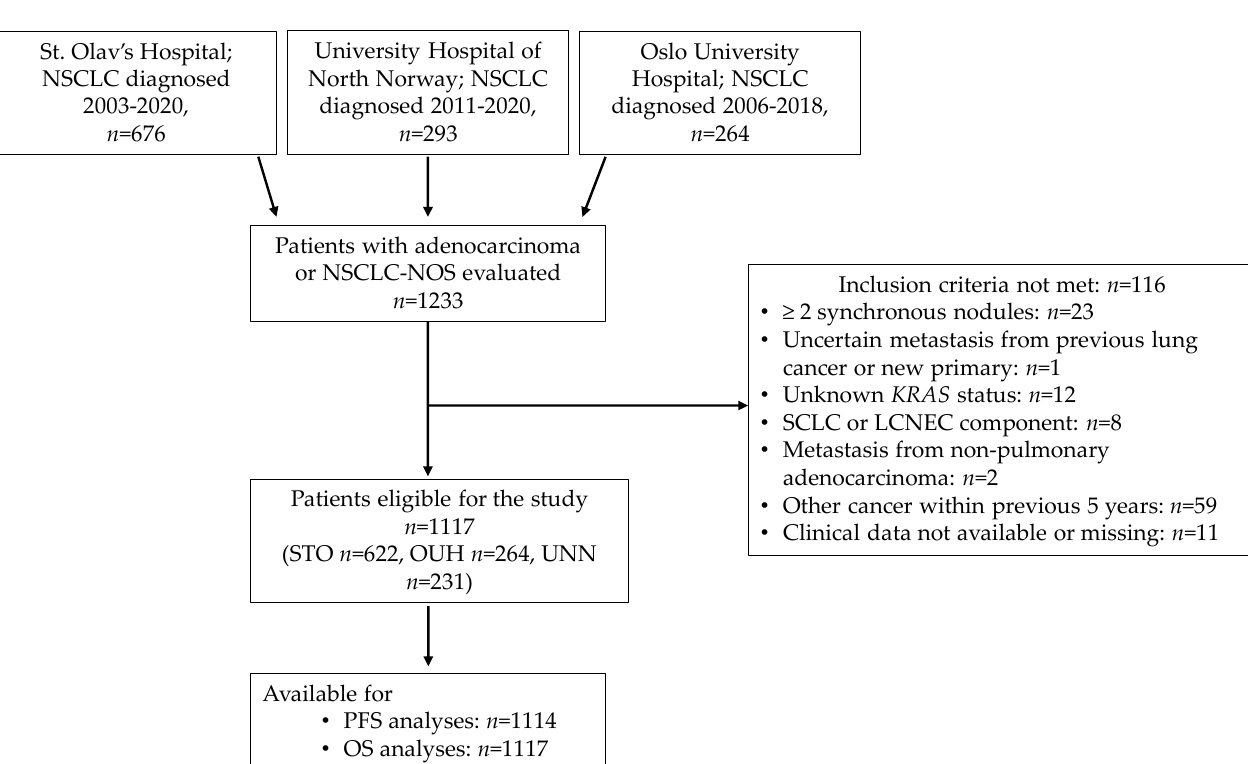
Figure 1. Outline of patient selection. Abbreviations: NSCLC, non-small cell lung carcinoma; NOS, not otherwise specified; STO, St. Olav’s Hospital; UNN, University Hospital of North Norway; OUH, Oslo University Hospital; SCLC, small cell lung carcinoma; LCNEC, large cell neuroendocrine carcinoma; PFS, progression free survival; OS, overall survival.